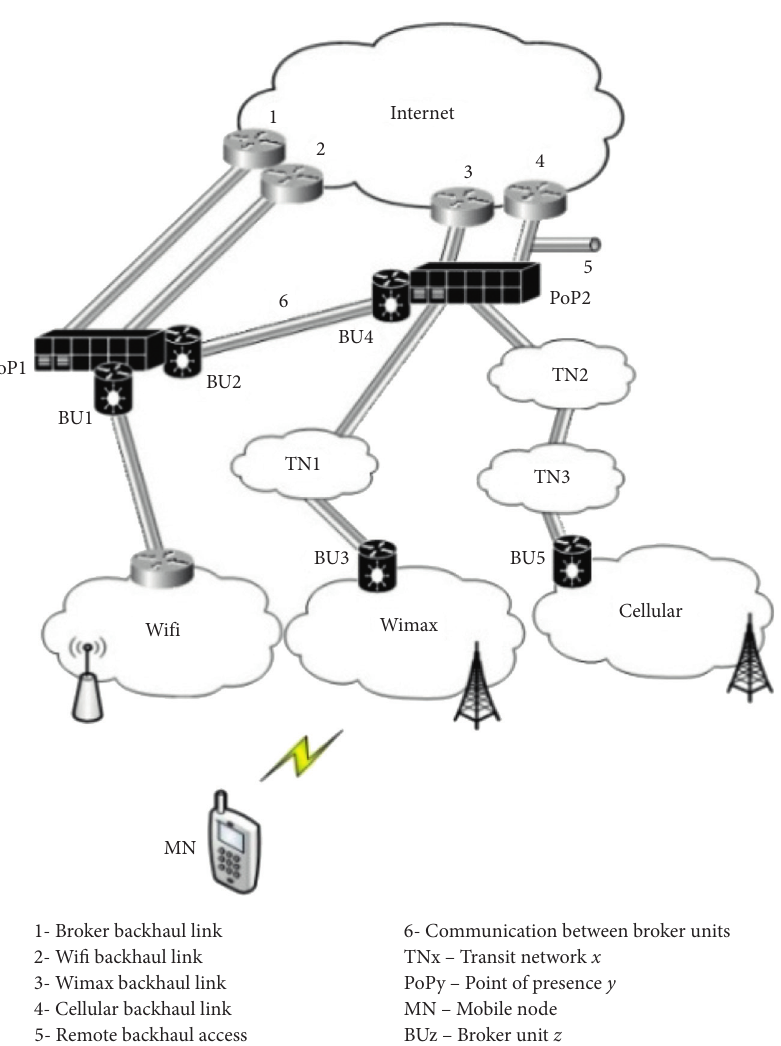
Figure 1: Scenario of the heterogeneous